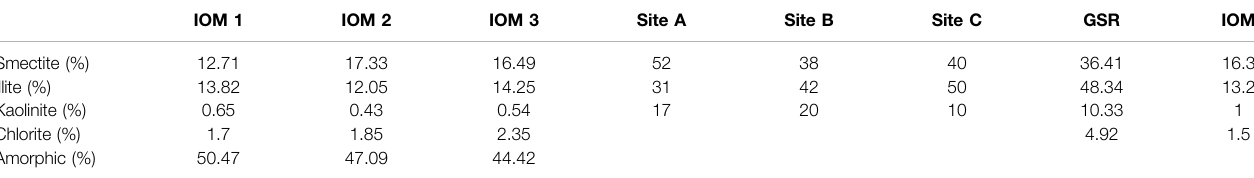
TABLE 3| Percentagesofmineralgroupsindeep-sea sediment.IOMdatafrom(Zawadzkietal.,2020),GSRdatafrom(GlobalSeaMineralResourcesNV,2018),SitesA-C (Bisschof et al., 1979). Note that for IOM 1, 2, 3, clay mineral % is given relative to total sediment. For Site A, B, C and GSR clay mineral % is relative to sum of clay minerals